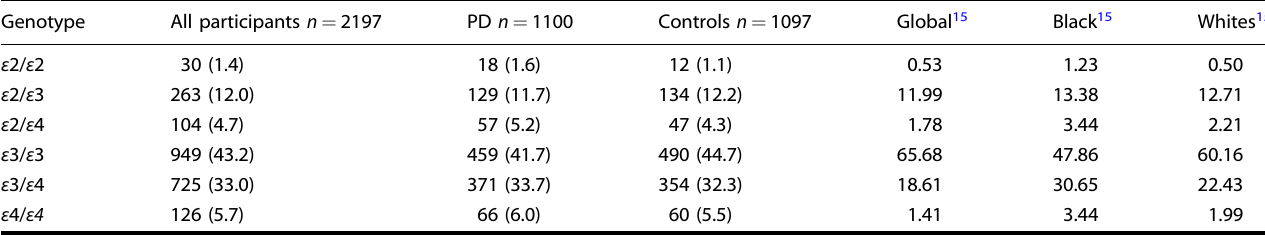
Table 2. APOE genotype distribution in Nigerians with PD and controls in comparison to other normal global and ethnic populations. Genotype